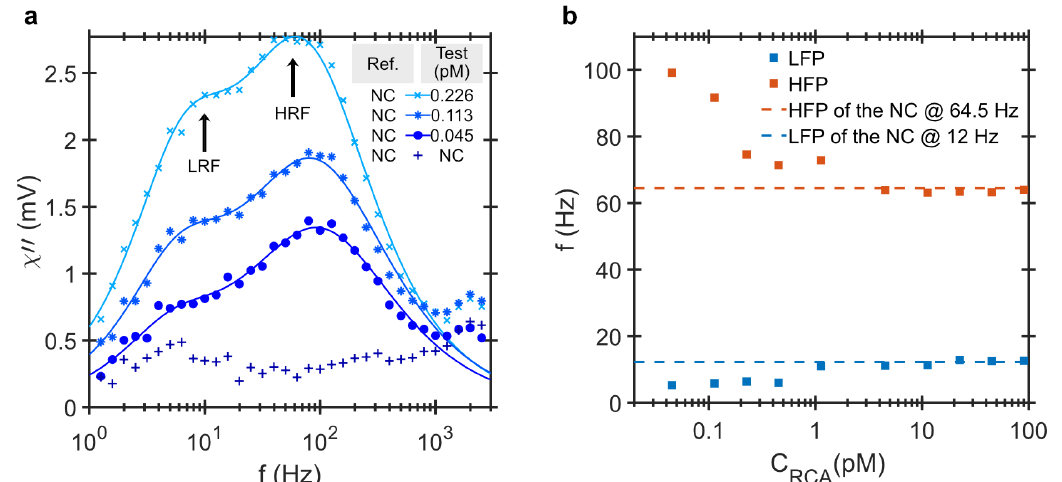
Figure 3. The binding process between MNPs and RCPs rolled for 20 min at low RCP concentrations. ( a ) Imaginary component of differential ac susceptibility versus the frequency for three RCP concentrations, 45 fM, 113 fM and 226 fM diluted in PBS buffer which results in slightly higher values for LRF and HRF compared to samples presented in Figures 1 and 2 due to lower viscosity of the buffer. The lines are the result of fitting to a bi-modal relaxation model. There are two frequency components visible in the imaginary part of the differential ac susceptibility and they are defined as the low relaxation frequency peak (LRF) and the high relaxation frequency peak (HRF); ( b ) The LRF and HRF are extracted from fitting the bi-modal relaxation model to the imaginary component of the differential ac susceptibility versus the RCP concentration. For high RCP concentration, the values of both the LRF and HRF are shifted to 12 and 64.5 Hz, respectively. These two frequencies corresponds to the LRF and HRF of the intrinsic bi-modal distribution of the NC sample in PBS